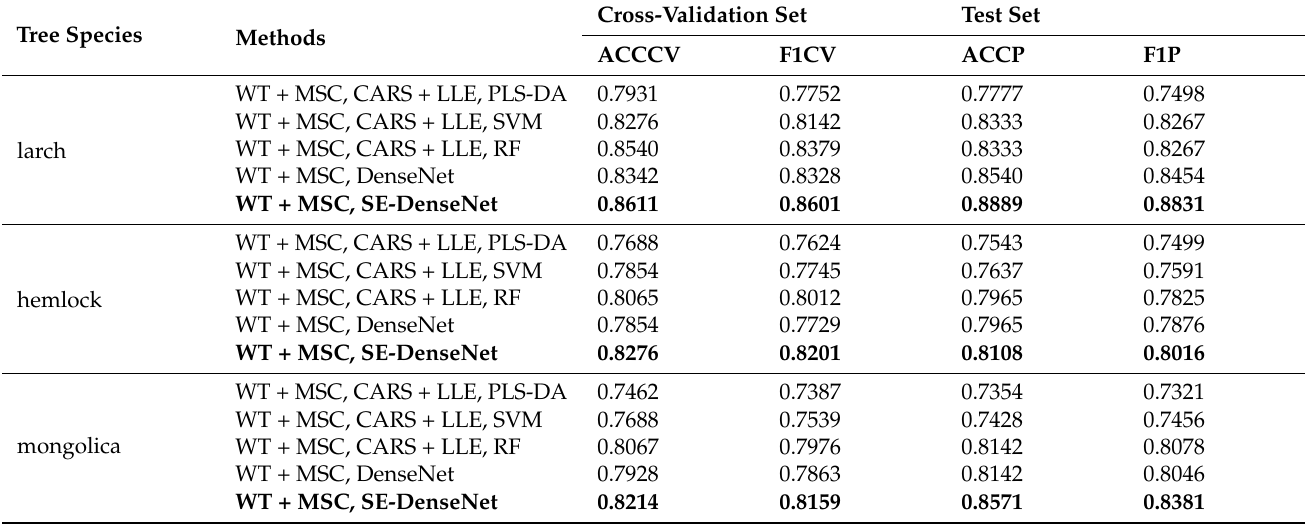
Table 7. Comparison of the results of the classification methods of strength level.